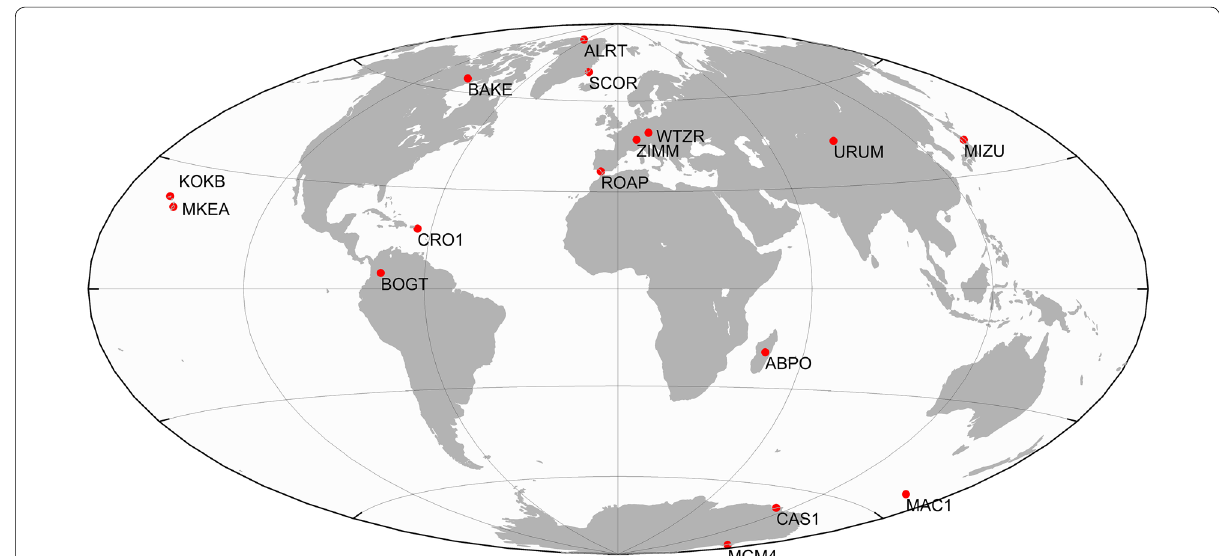
Fig. 1 Location of the GPS stations analyzed in the position domain